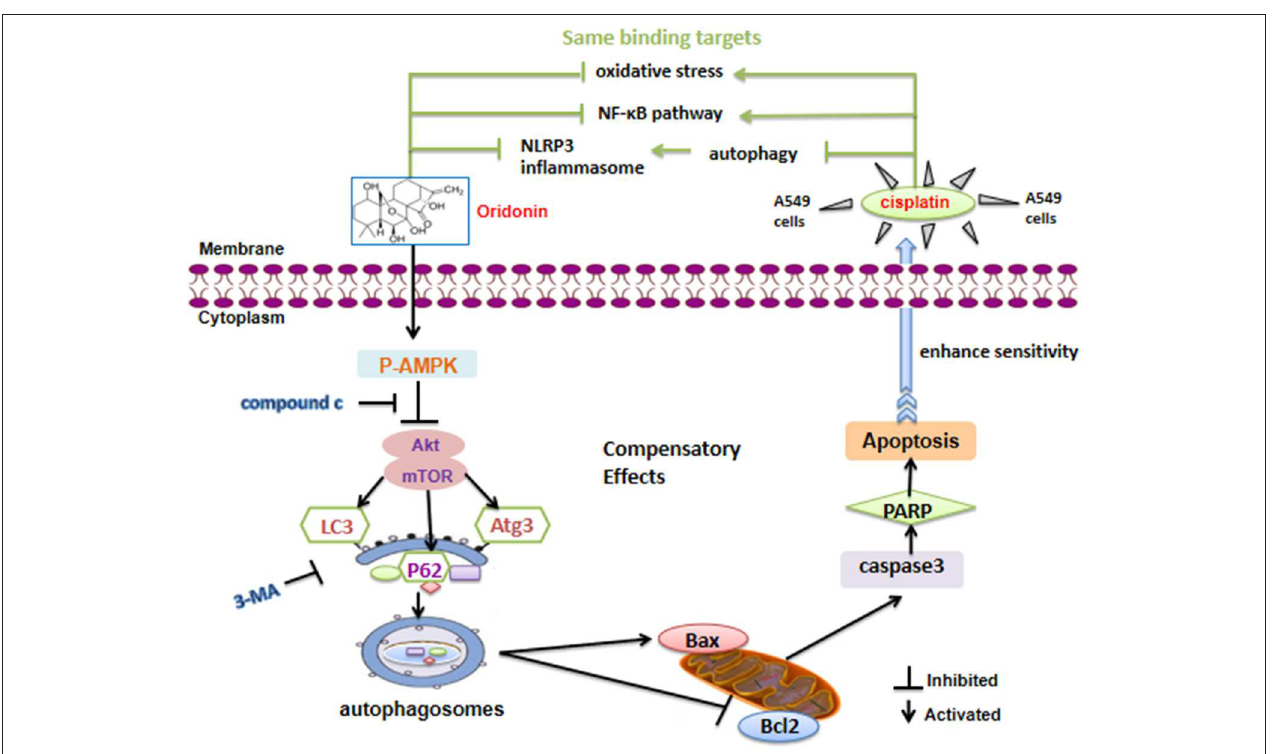
FIGURE 7 | Schematic model of the increased cisplatin sensitivity by Ori in A549 cells. Ori induced apoptosis and enhanced the chemotherapeutic efficacy of cisplatin via AMPK/Akt/mTOR-dependent impaired autophagosome accumulation (black lines). And the same binding targets between Ori and Cis were also exhibited (green